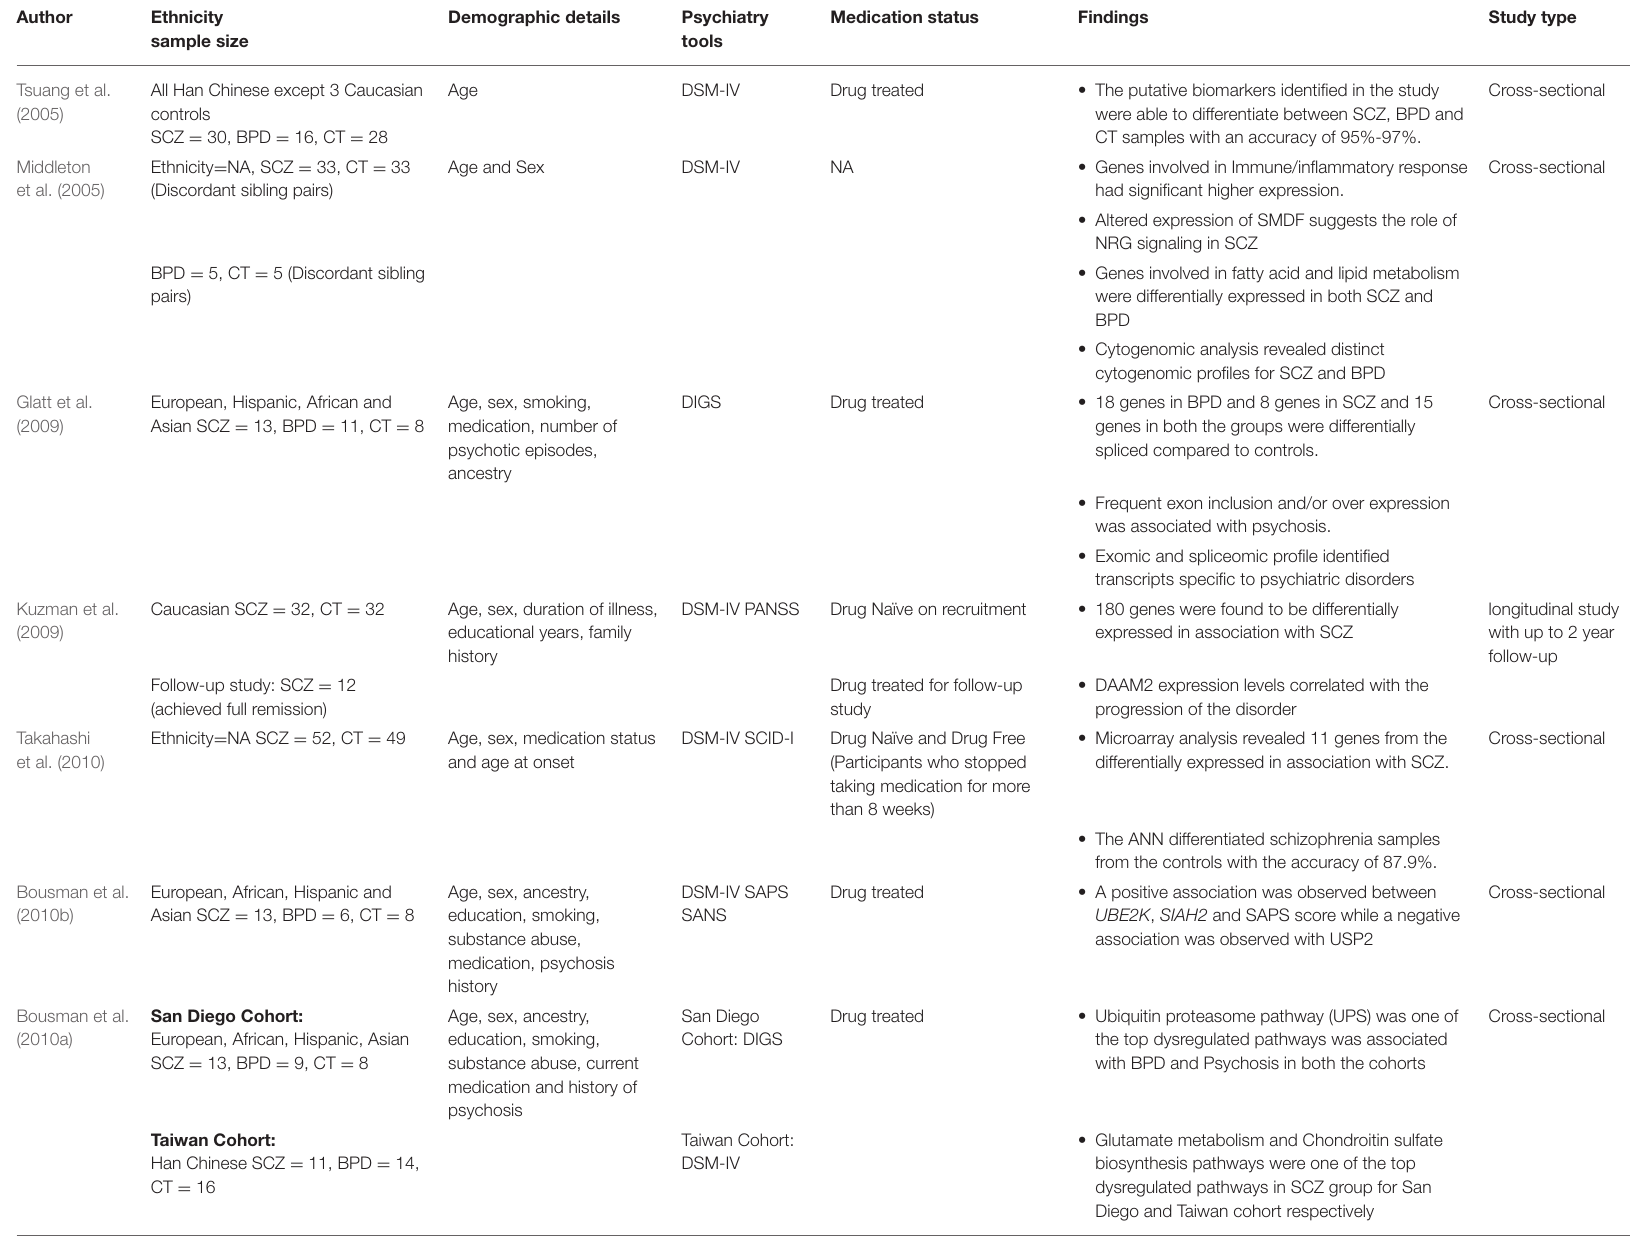
TABLE 1 | Summary of 15 microarray studies included for the preliminary